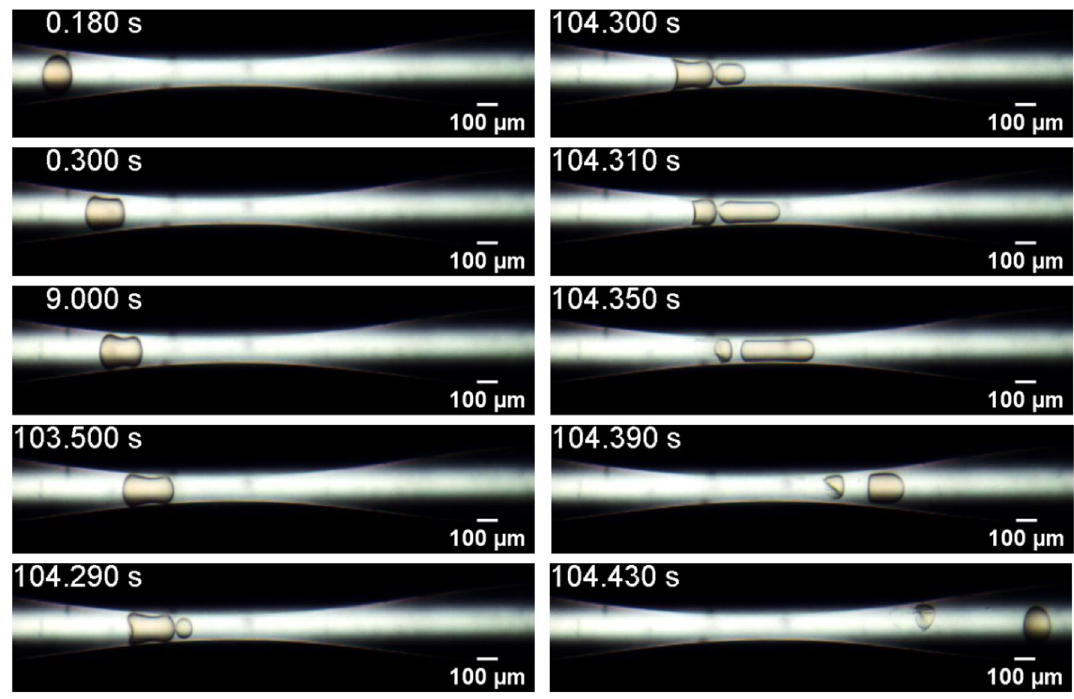
Figure 6. Evolution of the microcapsule position and configuration as it flows through the constriction. System #1, D = 174.6 μm and h = 15.0 μm ( a = 1.75 and Ca s = 6.0 × 10 inner content.